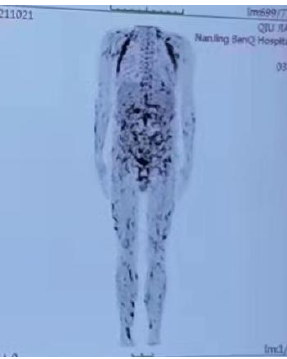
Figure 4. PET/CT revealed widespread increased metabolic